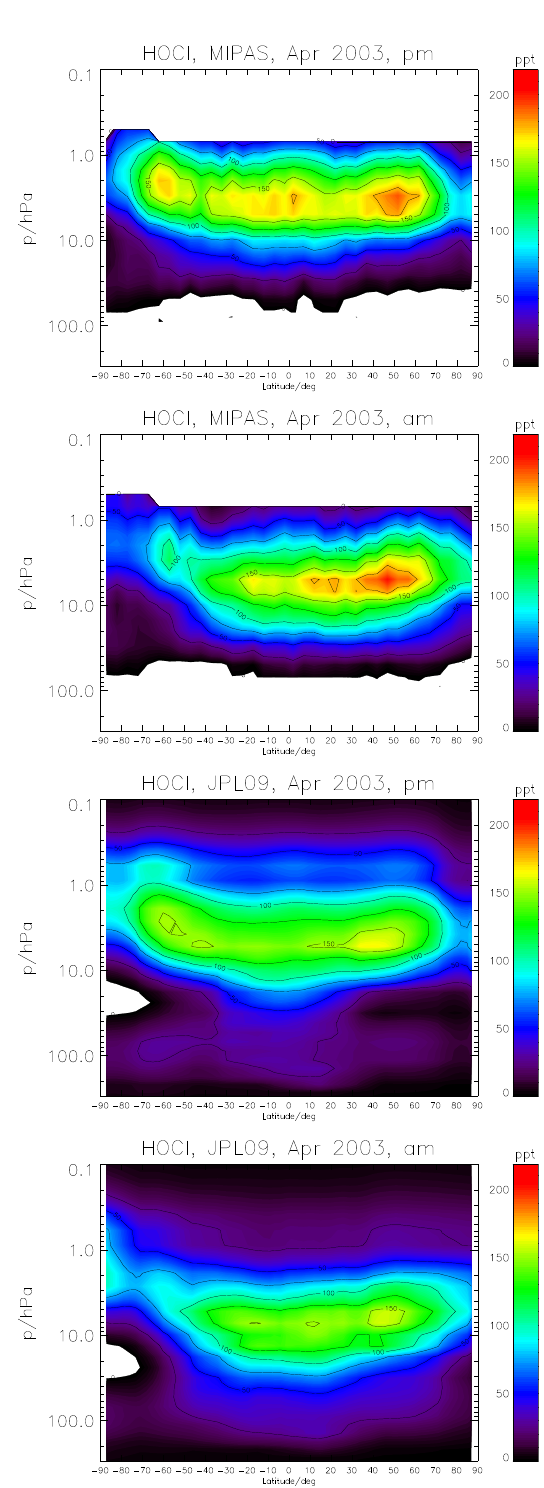
Fig. 4. MIPAS zonal mean HOCl distribution in April 2003 at 10:00 p.m. (top panel) and 10:00 a.m. (second panel), and respective model calculations (third and fourth panel).